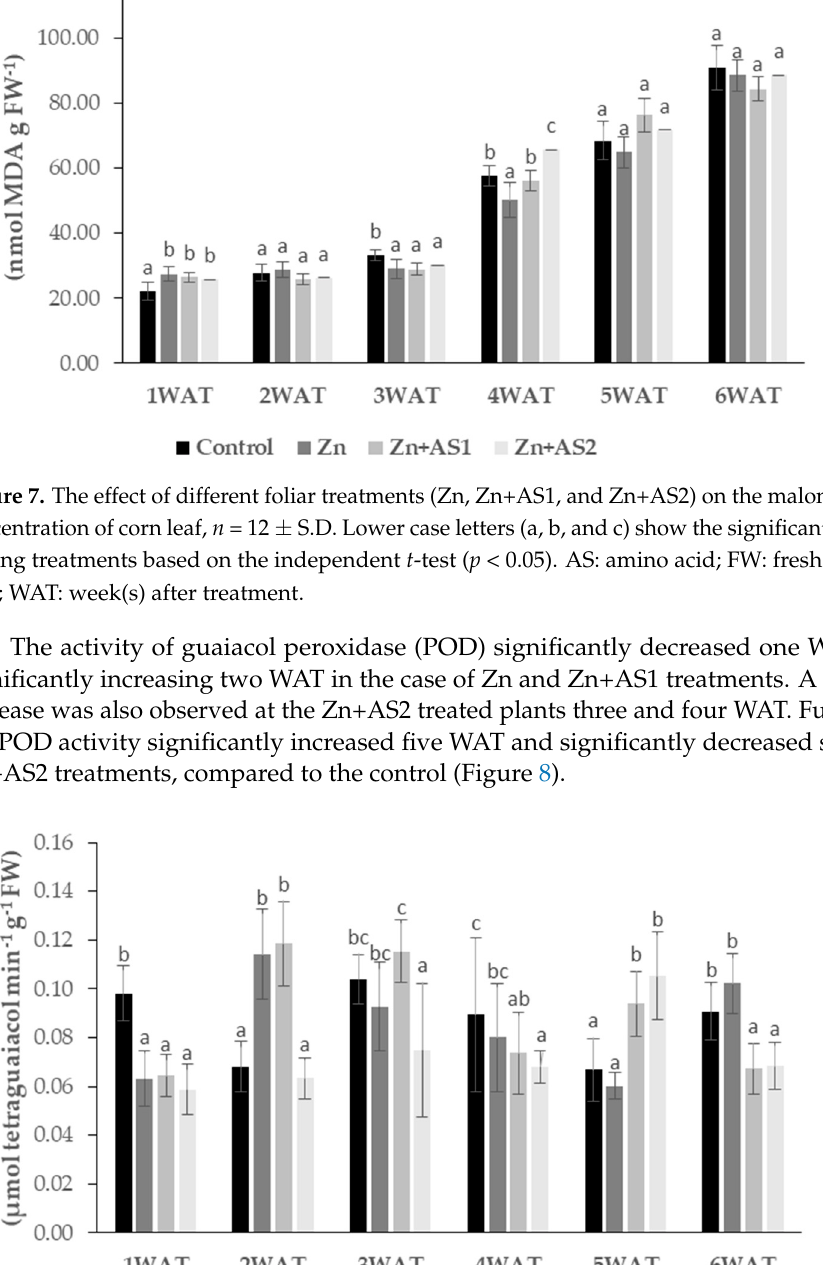
four WAT. There was a significant difference between five WAT (Zn+AS1 and Zn+AS2) and six WAT (Zn+AS2), compared to the control (Figure